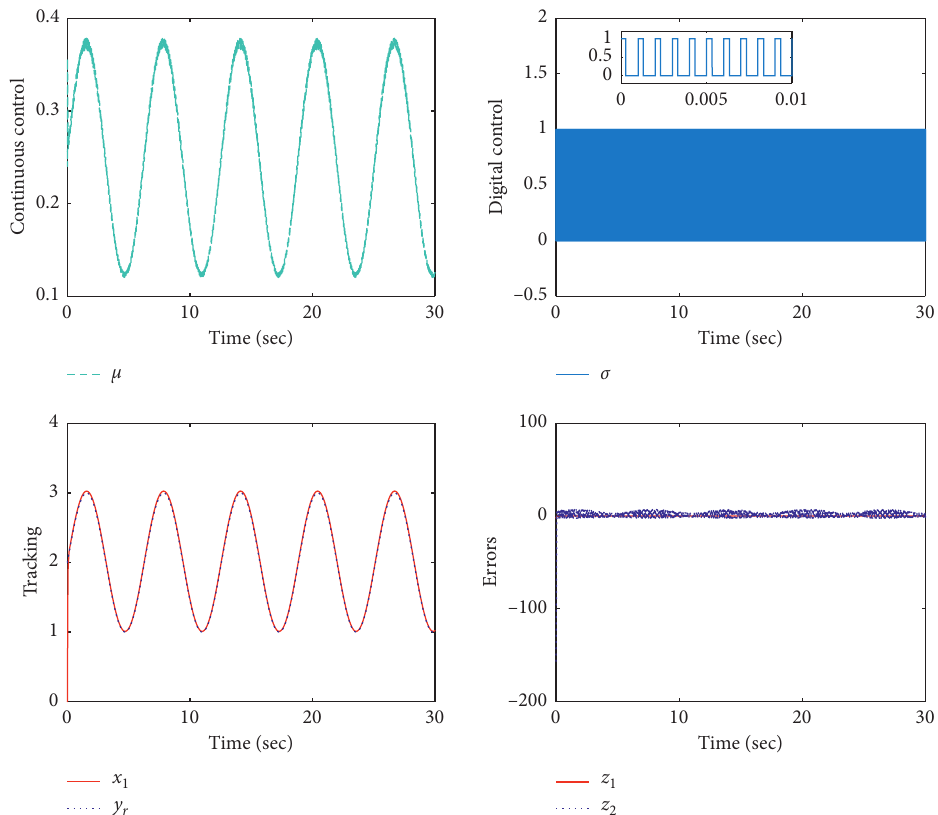
Figure 7: The response of closed-loop switched buck converter (3) with PWM control